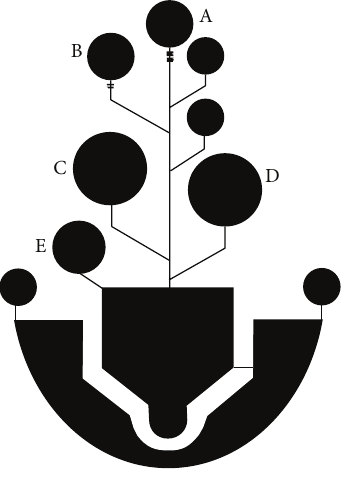
Figure 7: Chip design for blood typing